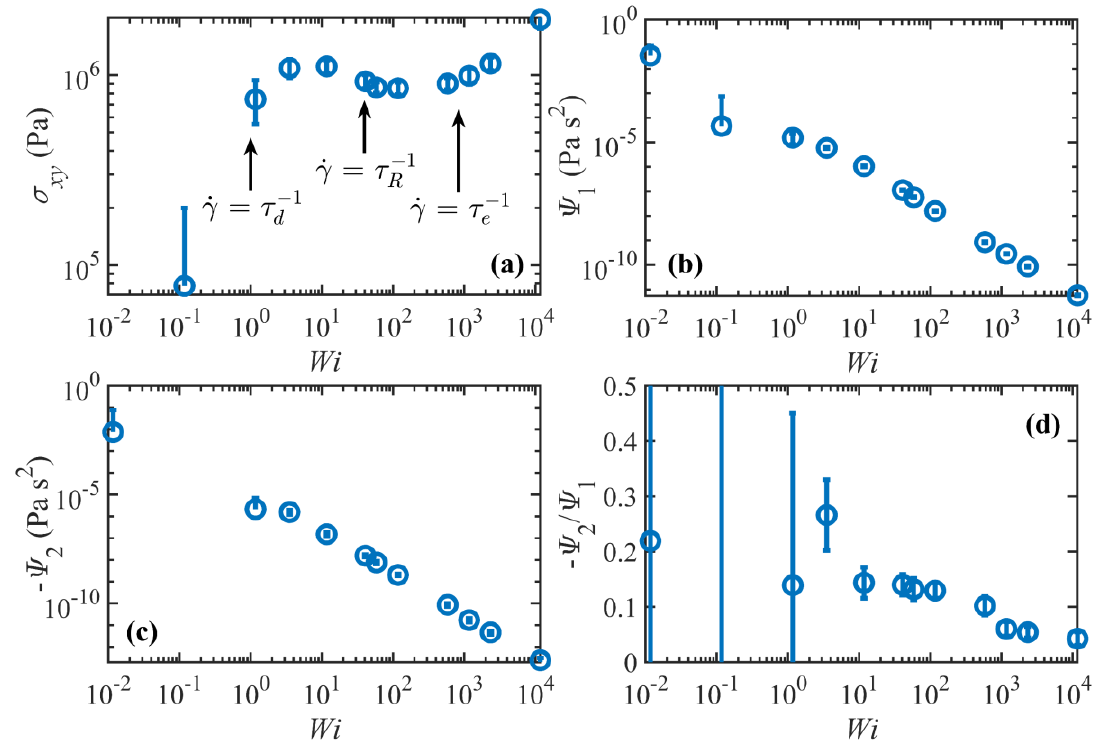
Figure 8. Shear stress ( a ), first and second normal stress coefficients ( b ), ( c ), and the ratio of the normal stress coefficients ( d ), all as functions of Wi